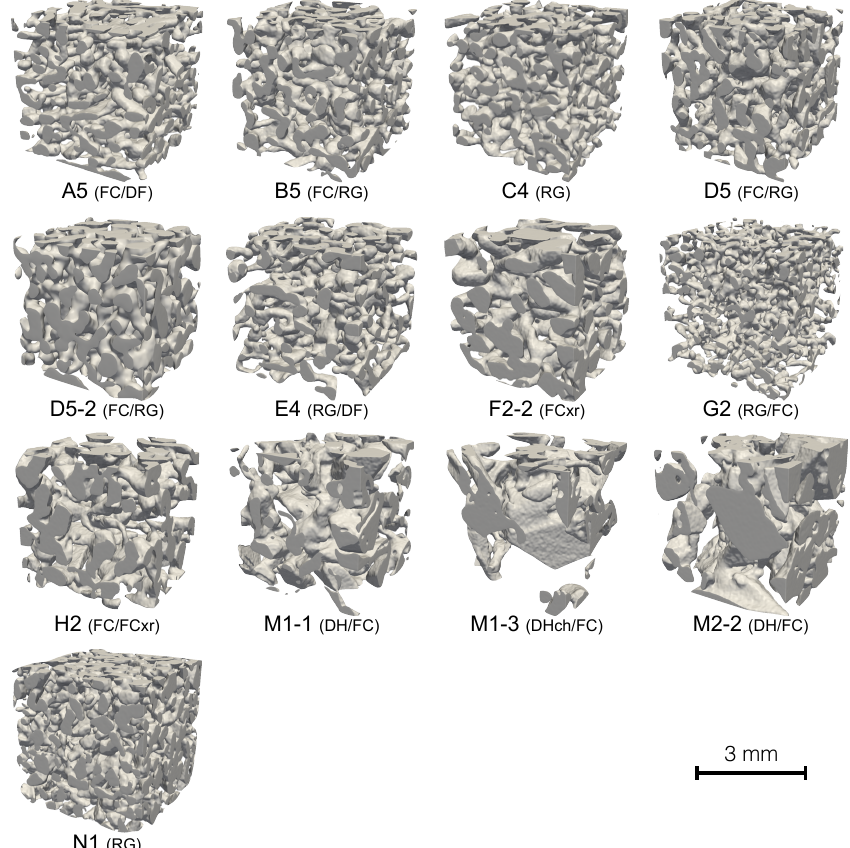
Figure 1. The different snow types and microstructural patterns used in this study. The 3-D images shown have a side length of 3mm and correspond to a subset of the images analysed in the present study. The grain shape is also indicated in brackets below the images, according to the international snow classification (Fierz et al., 2009).